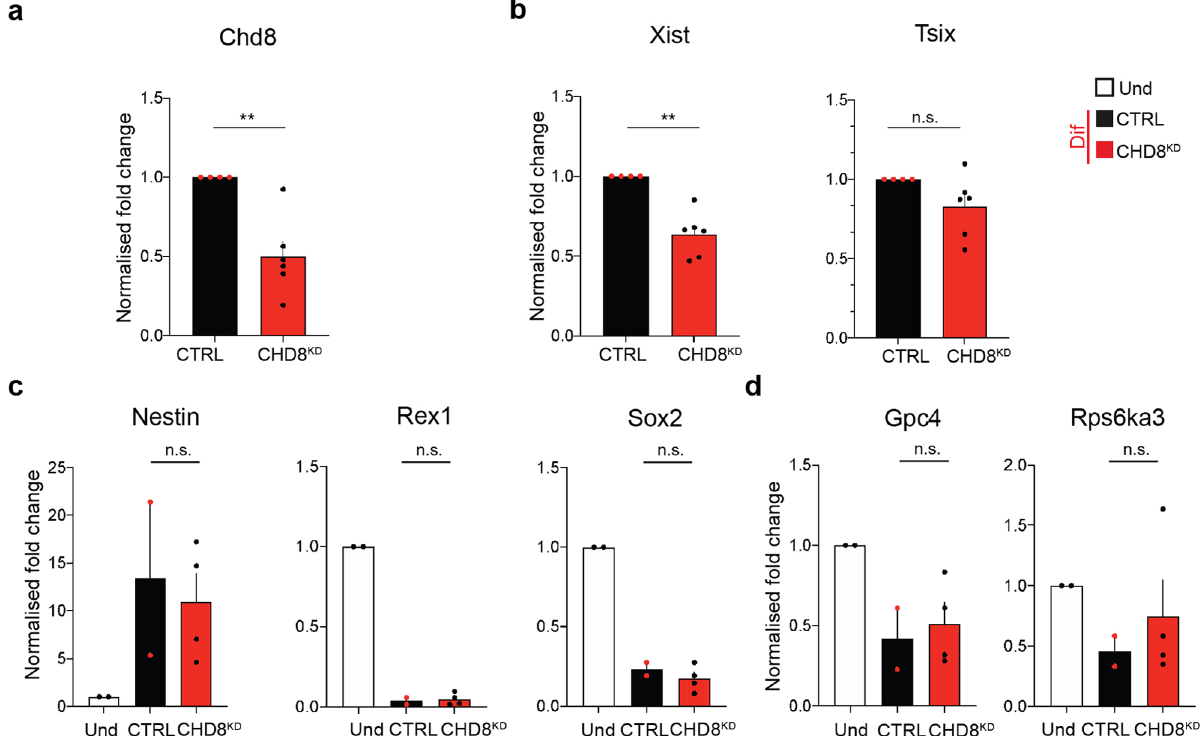
Fig. 2 Chd8 KD leads to Xist de-regulation. a CTRL-normalised Chd8 qRT-PCR at 3-day differentiated cells in CTRL and Chd8 KD cells is shown. CRTL: scrambled siRNA control (black bars), Chd8 KD : speci fi c siRNA pool to Chd8 (red bars). Data from three independent experiments is shown. b CTRL- normalised Xist and Tsix qPCR at 3-day differentiated cells in CTRL and Chd8 KD cells is shown. CRTL: scrambled siRNA control (black bars), Chd8 KD : speci fi c siRNA pool to Chd8 (red bars). Data from three independent experiments is shown. c Selected differentiation markers used for qRT-PCR analysis are shown. Data is normalised for the undifferentiated condition (Und). Data from two independent experiments is shown. d Xist -mediated gene silencing is not affected in Chd8 KD (two randomly selected X-linked genes are showed). Data is normalised for the undifferentiated condition (Und). Data from two independent experiments is shown. Und (undifferentiated cells), Dif (3 day differentiated cells). Error bars represent standard error of the mean (SEM). Statistical signi fi cance was tested by means of two-tailed unpaired t -test (* p ≤ 0.05; ** p ≤ 0.01). p -values, Xist = 0.00141, Chd8 = 0.00390. Single points represent independent biological samples. Gapdh was used as internal normalization